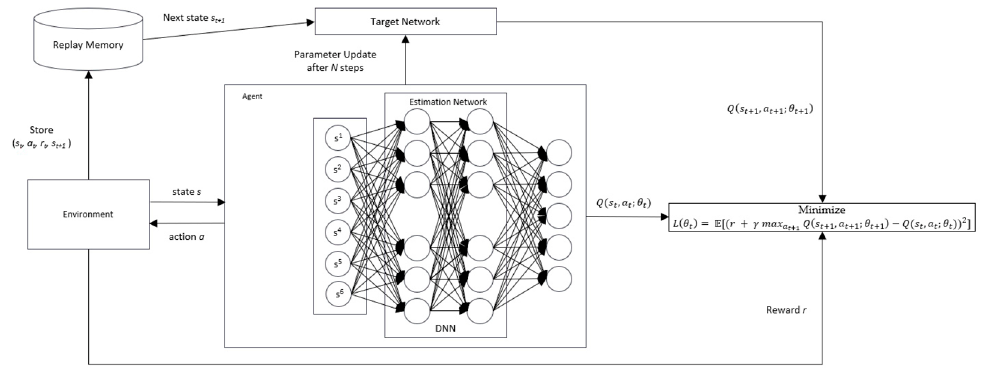
Figure 3. Deep Q-network structure